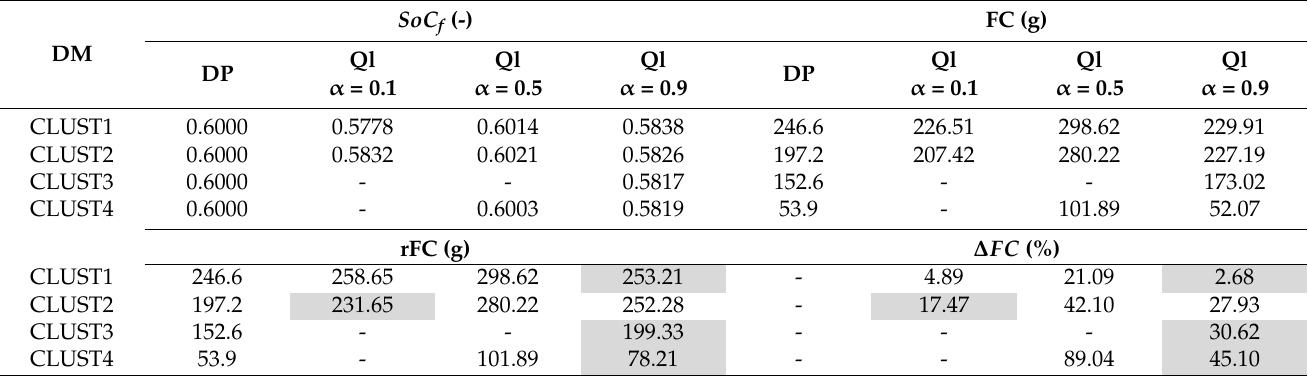
Table 6. Results produced by a sensitivity to α considering α = 0.1, α = 0.5 and α = 0.9.